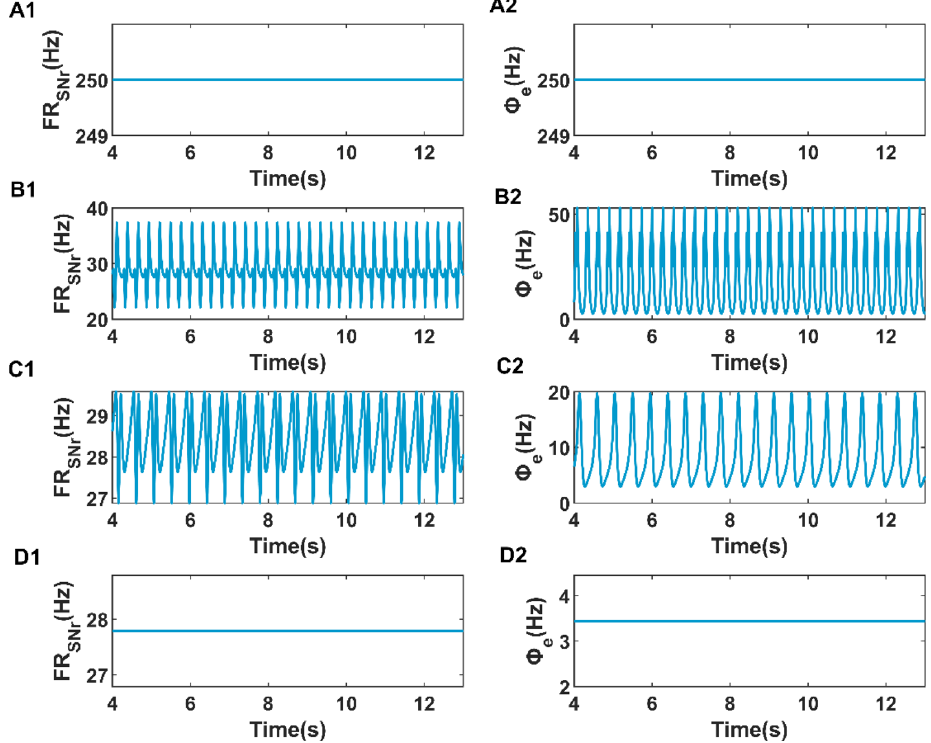
Figure 6. The four main kinds of firing activities (right) of the cerebral cortex and the corresponding firing rate (left) of the SNr. The firing activities of ( A2 , B2 , C2 , D2 ) correspond to saturation state, SWDs state, simple oscillation state and low firing state respectively and ( A1 , B1 , C1 , D1 ) show the firing rate of SNr in these four